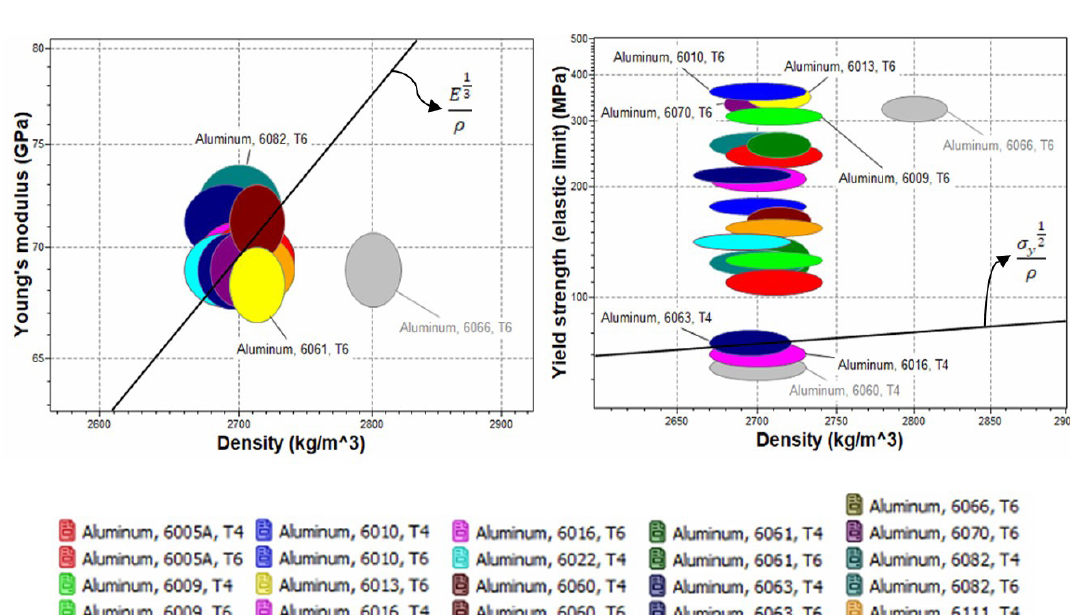
Figure 2. Property maps of the 6000 series alloys with their respective index lines taken from the Ansys® Granta EduPack and Selector software, ANSYS, Inc., 2022. Images used are courtesy of ANSYS,